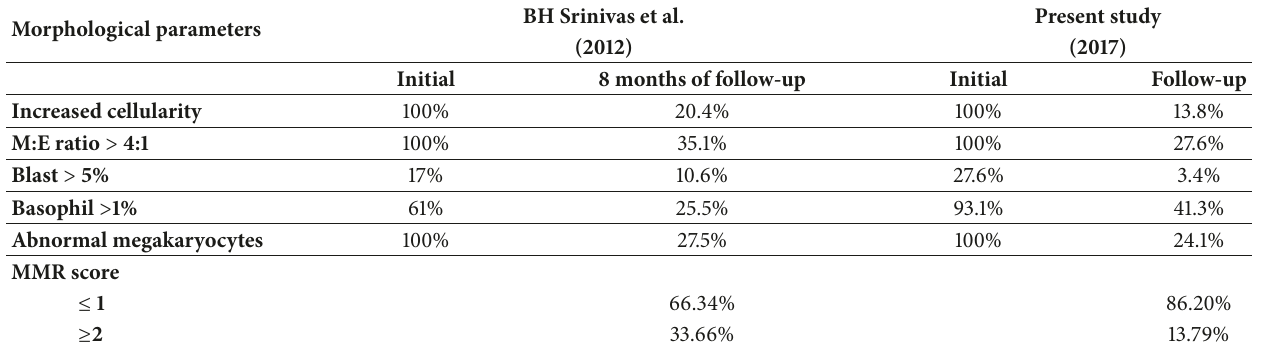
Table 6: Comparison of bone marrow morphological changes between the present study and previous studies. Morphological parameters